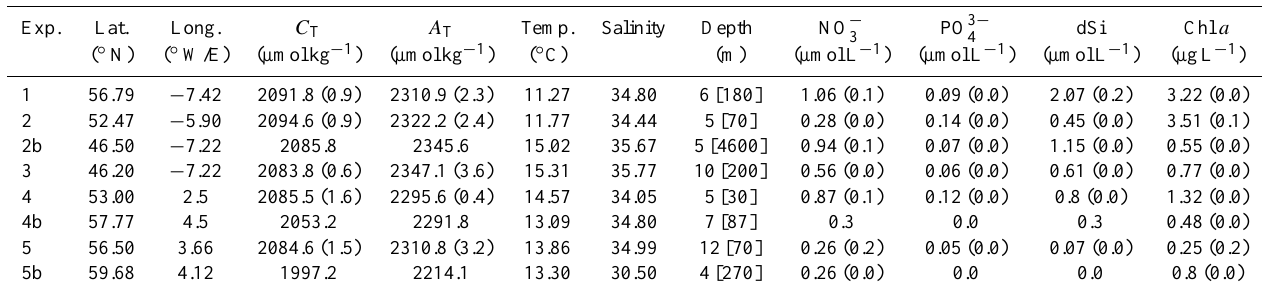
Table 2. Starting conditions in the bioassay experiments. Data for salinity and temperature (Temp.) were determined in situ using the CTD. Average ( ± standard deviation) values are given when available. The total depth of the water column at the sampling sites is indicated after sampling depth in square